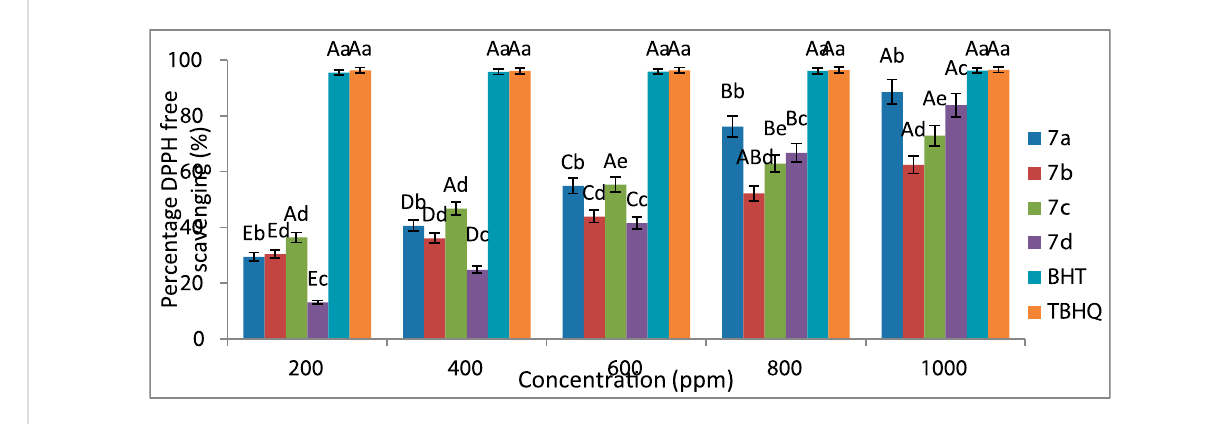
FIGURE 1 Order of the antioxidant activity of 7a – 7d using